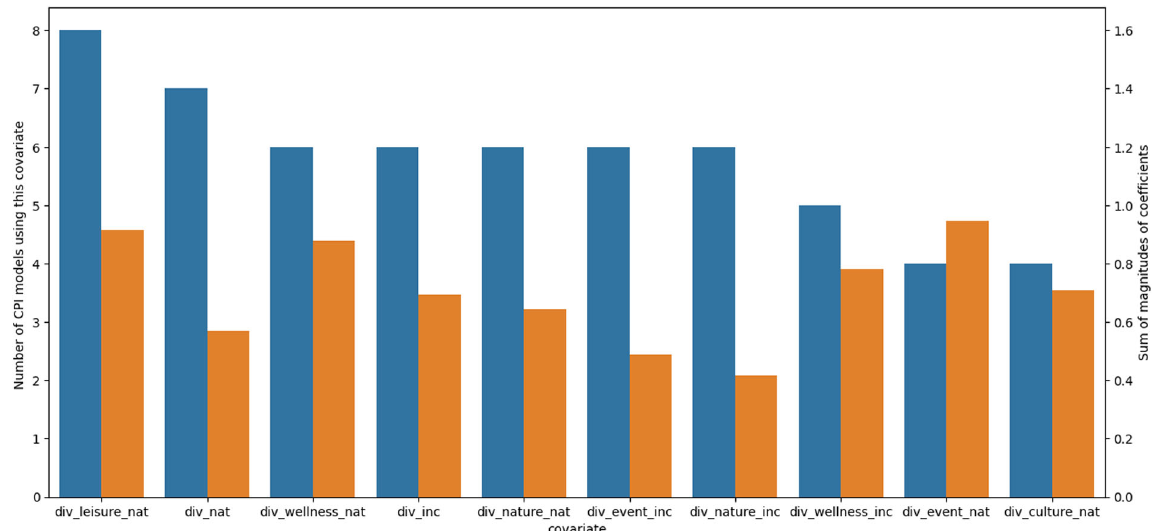
Fig. 6 Covariate importance. The number of models selected this covariate (the y -axis on the left) and the sum of coef fi cients in all models (the y -axis on the right). The x -axis corresponds to the top covariates selected by both